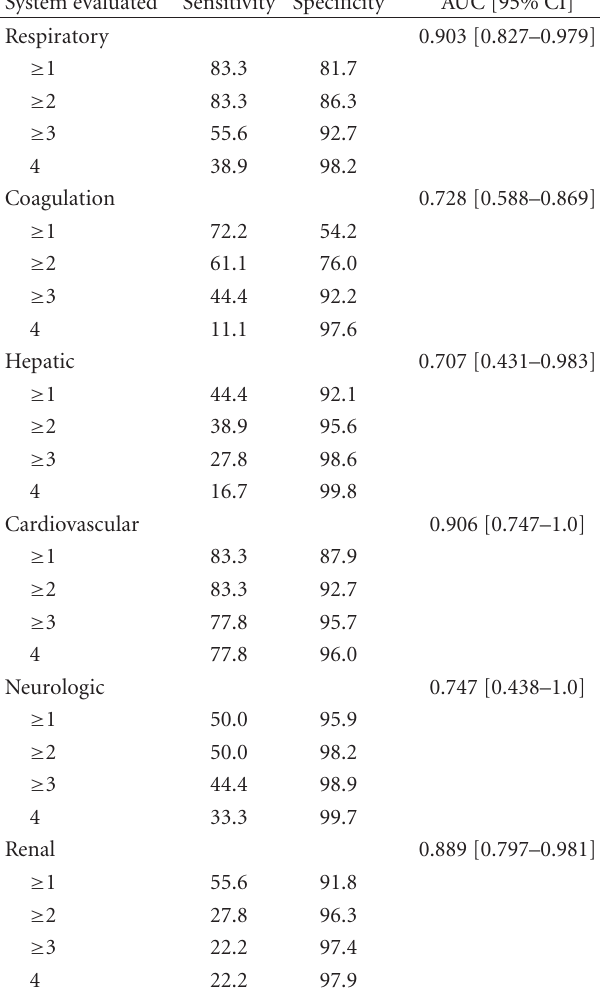
Table 3: Values of sensitivity and specificity of individual maximum Sequential Organ Failure Assessment (SOFA) score of each system evaluated, for the prediction of maternal death, according to cuto ff points of the